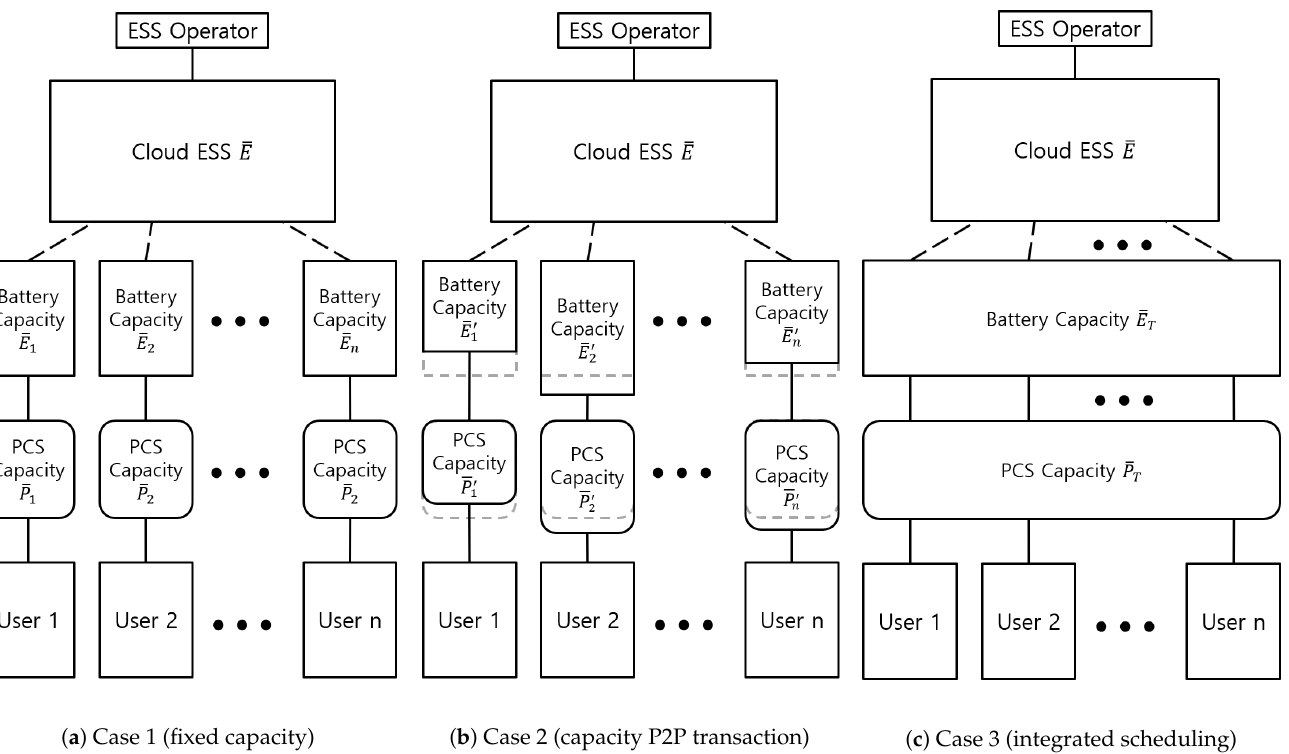
Figure 1. CESS structures for each